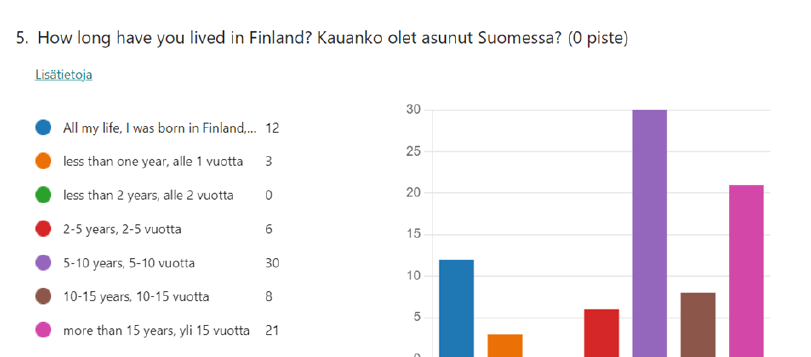
Figure 4. Duration of living in Finland: More than 90% have lived for at least 5 years in Finland. Source: (Authors’